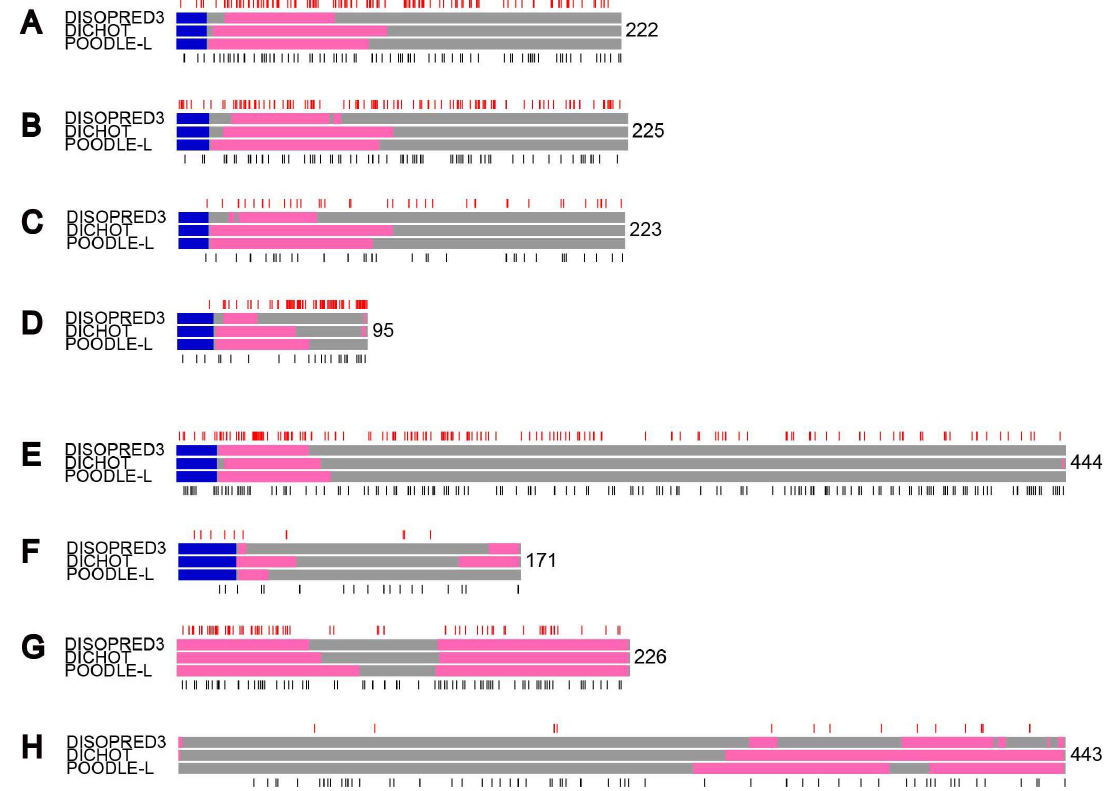
Figure 4. Examples of proteins with locations of nonsynonymous and synonymous substitutions. Each protein is represented by three rectangles with DISOPRED, DICHOT, and POODLE predictions (top to bottom) of IDRs (pink) and SDs (gray) as well as signal sequences (blue), if any, and the length shown on the right. The locations of nonsynonymous and synonymous substitutions are shown above (red lines) and below (black lines), respectively. ( A – D ): Immune-related secreted proteins, ( E , F ): non-immune-related secreted proteins, ( G , H ): nuclear proteins. ( A ) The human PRG2, ( B ) human PRG3, ( C ) mouse PRG2, ( D ) mouse DEFA20, ( E ) human SERPINA10, ( F ) mouse NENF, ( G ) human PROP1, ( H ) mouse NEK2 proteins.